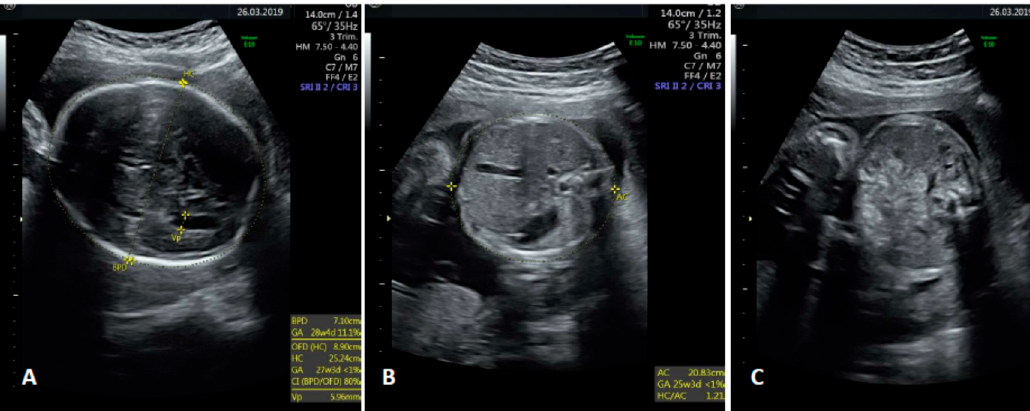
Figure 2. Fetal ultrasound findings for Case 2 at 30 + 3 weeks showing a normal brain in the transventricular plane ( A ), normal abdomen ( B ) and minor bowel echogenicity, consistent with the diagnosis of early onset fetal growth restriction ( C ). Neither hepatosplenomegaly nor other signs suggestive of fetal infection were detectable at that stage.